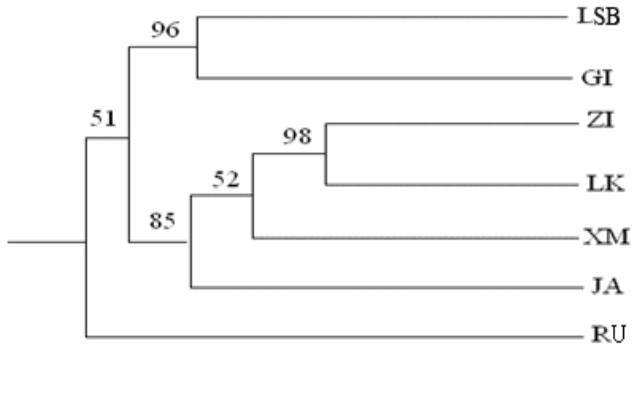
Figure 2. Population-wise similarity tree revealed by UPGMA cluster analysis using the Nei (1978) unbiased genetic identity measure. Significant bootstrapping values are indicated on